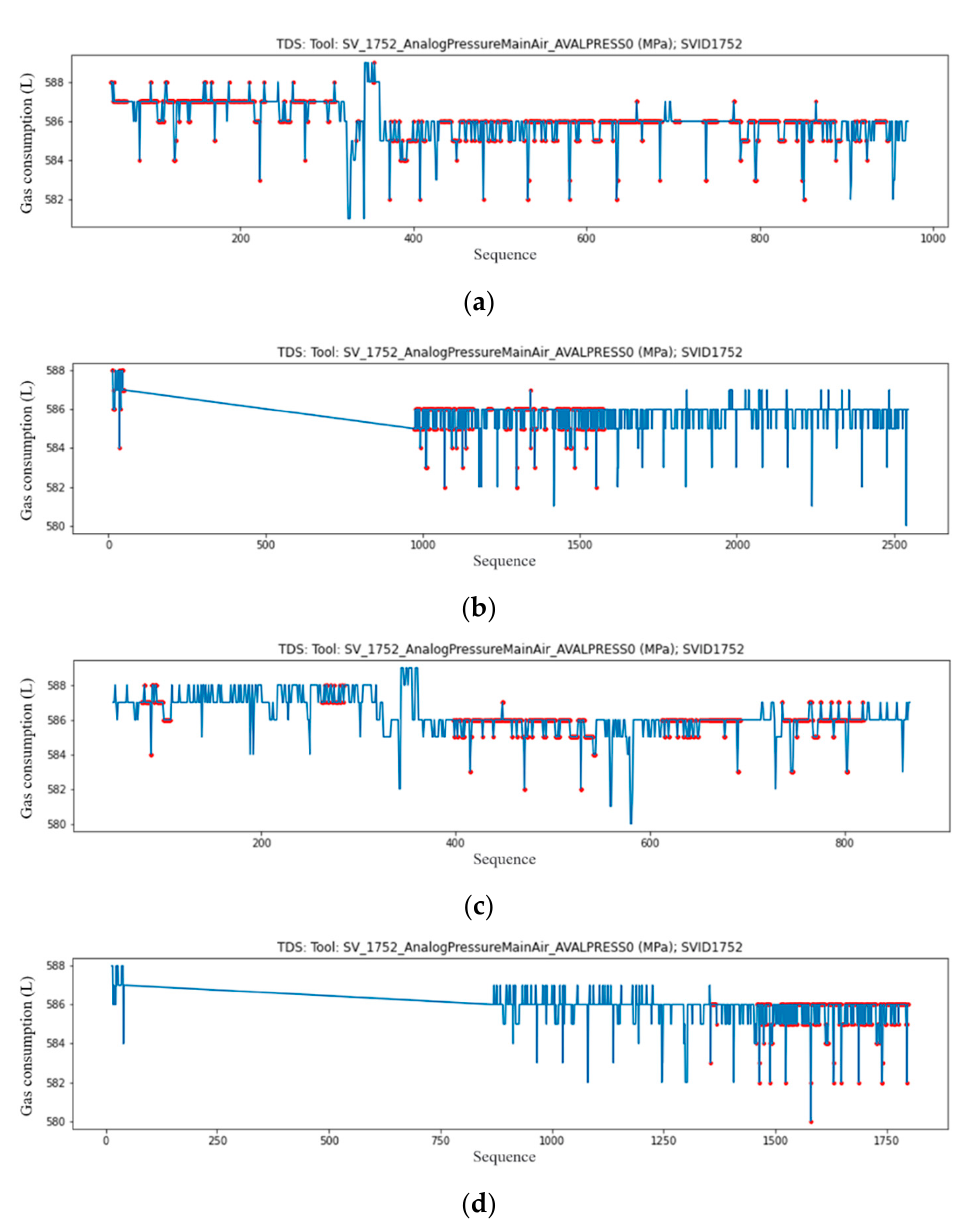
Figure 14. ( a ) mode CH1 in the wafer ID TR7VC470W12C2; ( b ) mode CH2 in the wafer ID TR7VC470W12C2; ( c ) mode CH1 in the wafer ID TR7W1101W04F7; ( d ) mode CH2 in the wafer ID